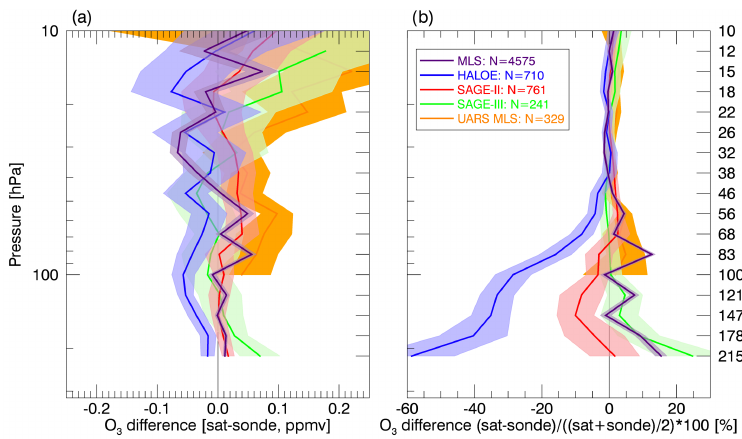
Figure 4. The difference as a function of height between matched satellite and ozonesonde observations. The number of matches at 82hPa is shown in the legend, and the mean difference (solid) and ± 2 standard error (2 σ/